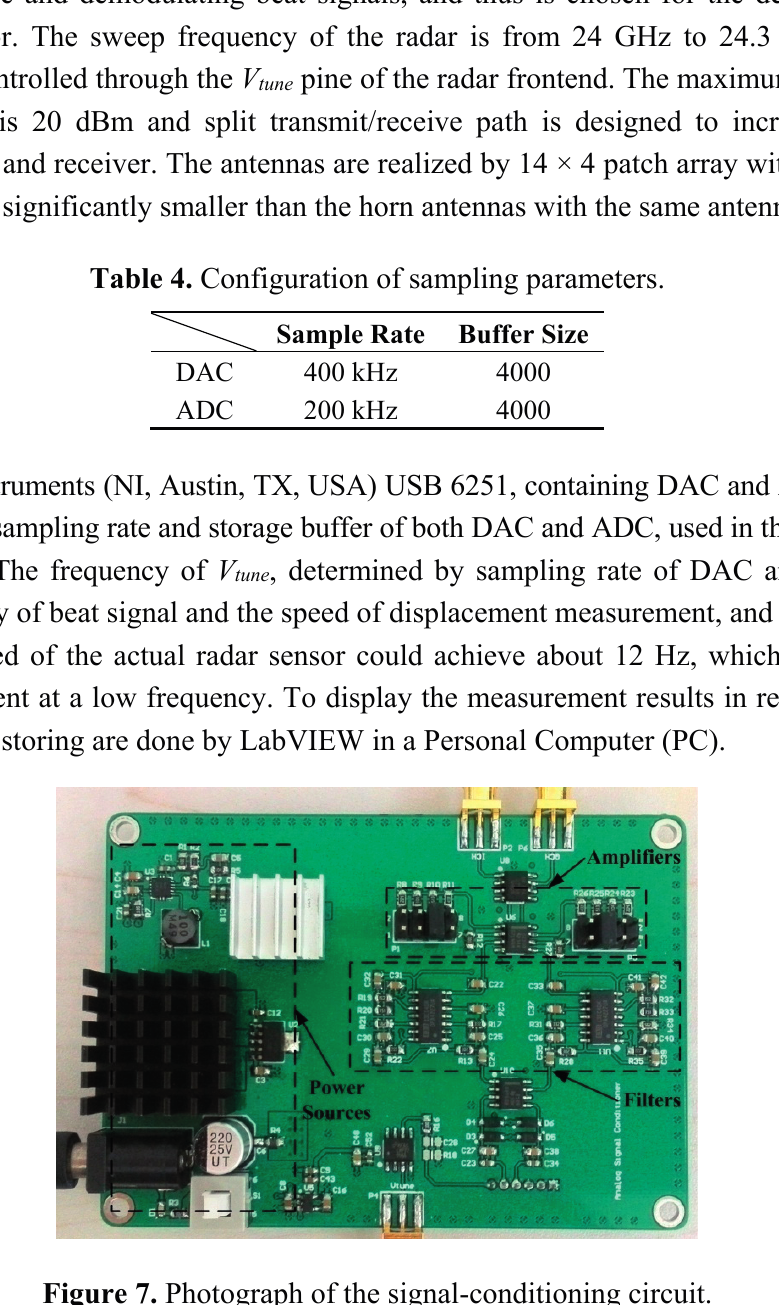
Figure 7. Photograph of the signal-conditioning